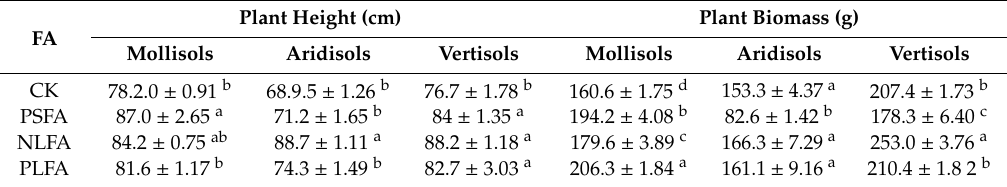
Table 3. E ff ect of FAs on the plant height and plant biomass content of wheat (g pot -1